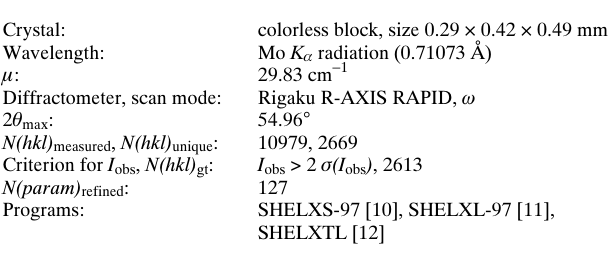
Table 1. Datacollection and